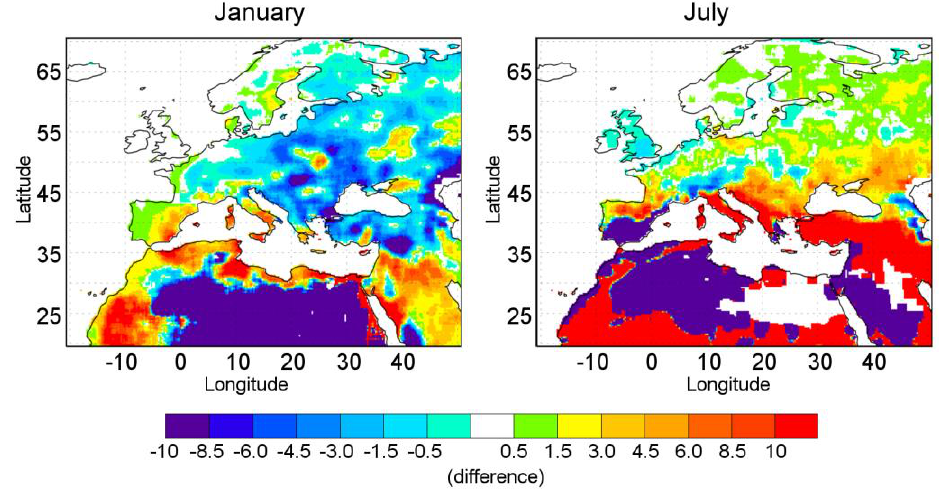
Figure 10. Difference between the percentages of the moisture from the Mediterranean Sea supplied to extreme events (see Figure 9) and to the mean climatology (see Figure 8).